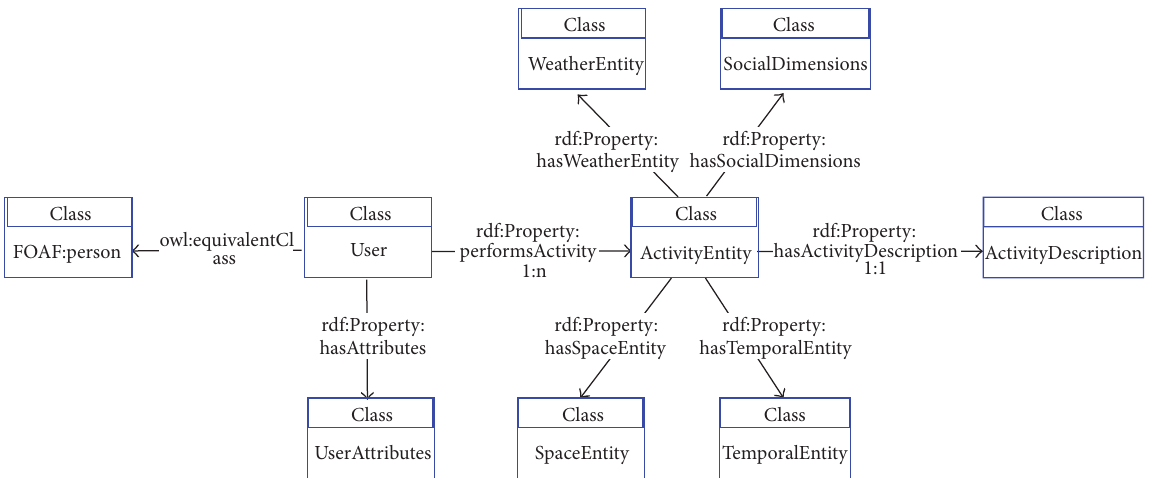
Figure 2: Conceptual diagram of the base classes intended for physical activity and inactivity classification.